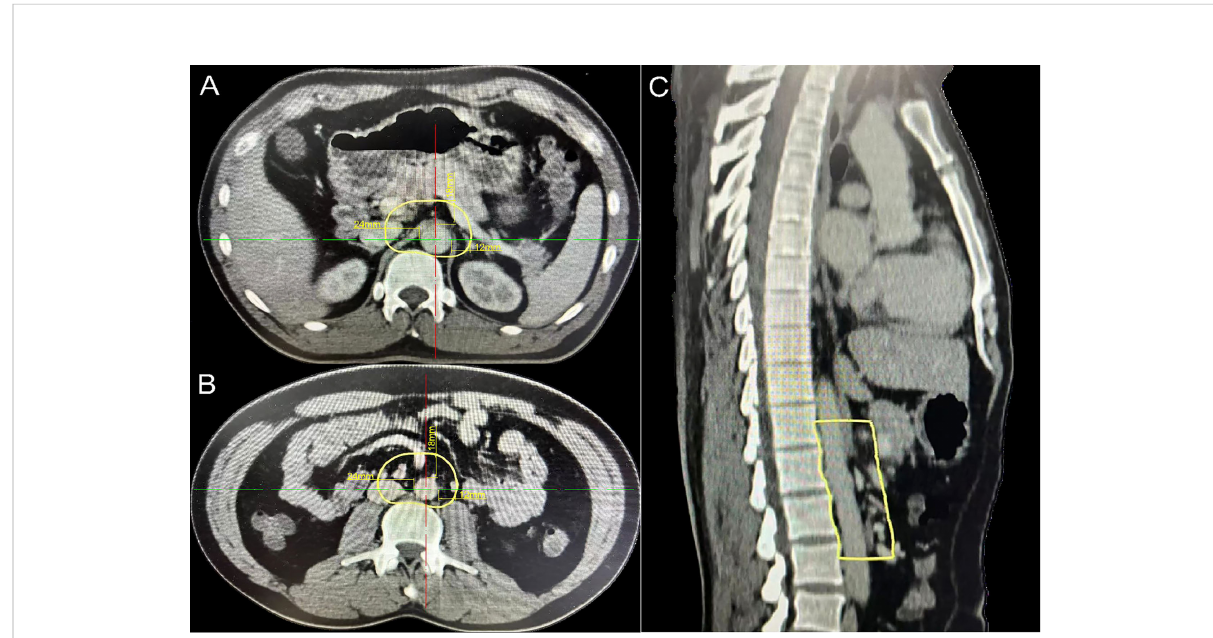
FIGURE 2 Proposed atlas of the para-aortic CTV in the study cohort. (A) The cranial border of the para-aortic CTV (aorta expansion with 18 mm in the front, 12 mm on the left, and 24 mm on the right). (B) The caudal border of the para-aortic CTV (aorta expansion with 18 mm in the front, 12 mm on the left, and 24 mm on the right). (C) Para-aortic CTV (sagittal plane). CTV, clinical target